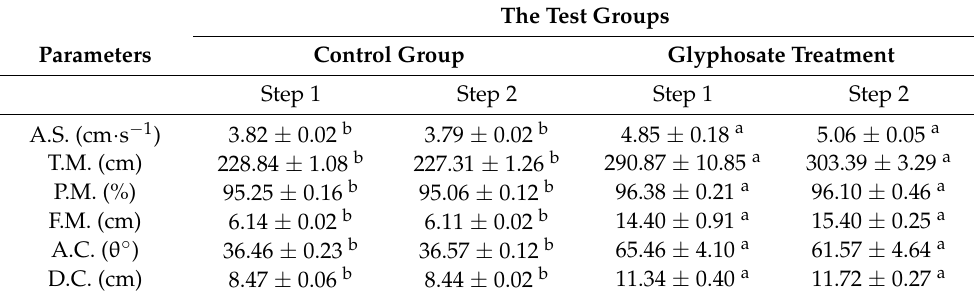
Figure 3. Parameters of swimming pattern of the fish in the control group: ( a ) average speed; ( b ) total movement; ( c ) fast Note: different lowercase letters ( a and b ) indicate significant differences ( p < 0.05) between the values in the same movement; ( d ) percent of movement; ( e ) average angular change of movement; ( f ) distance from the center. Similar low ‐ row ( p < 0.05). ercase letters (a) indicate nonsignificant differences between values of the same color columns ( p > 0.05). Similar uppercase letters (A) indicate nonsignificant differences between values of paired columns ( p > 0.05).